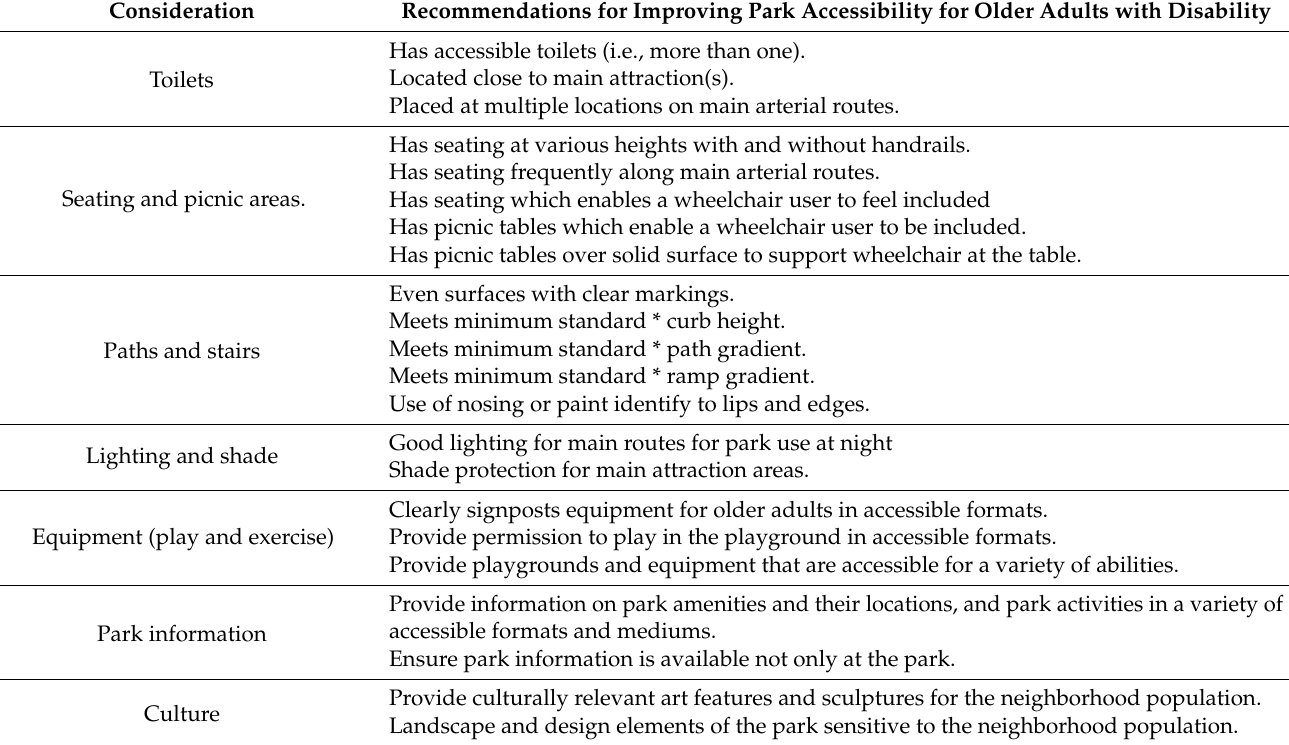
Table 4. Synthesis of accessibility considerations by older adults with